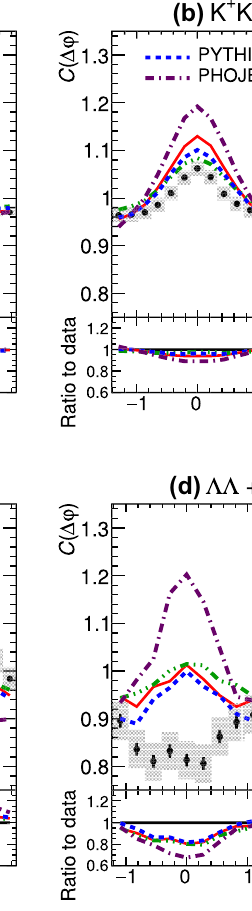
els(PYTHIA6Perugia-0,PYTHIA6Perugia-2011,PYTHIA8Monash, PHOJET). Bottom panels show ratios of MC models to ALICE data. Statistical ( bars ) and systematic ( boxes ) uncertainties are plotted